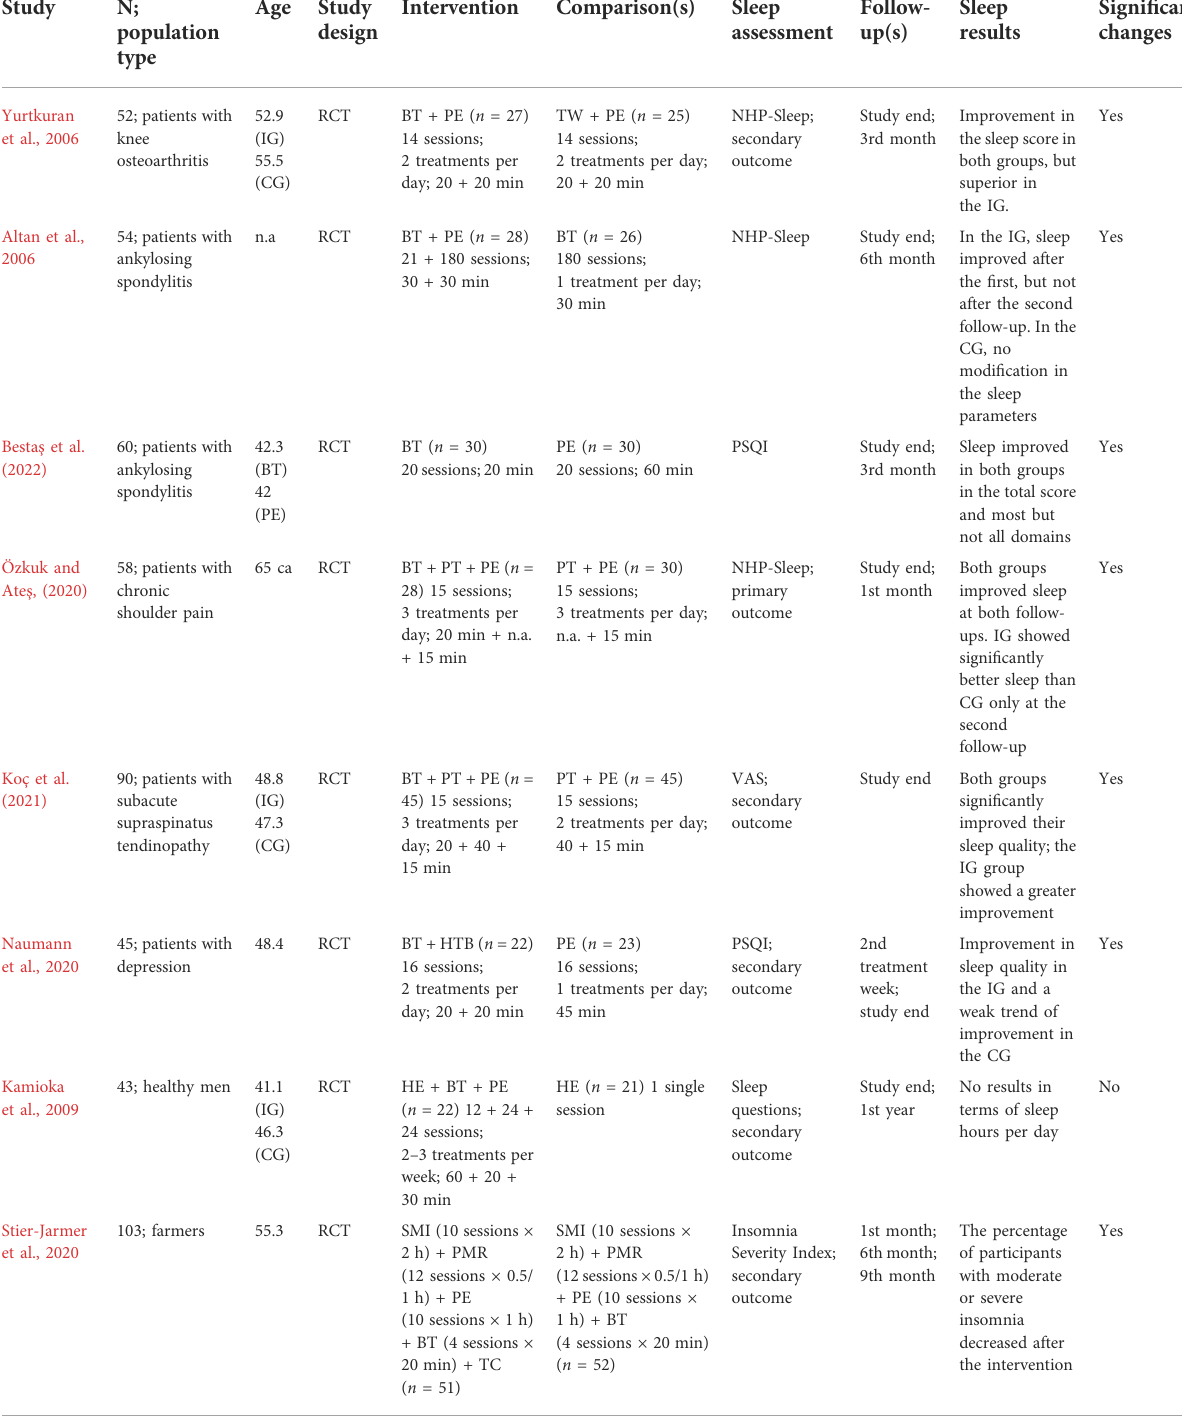
TABLE 3 Balneotherapy and physical exercise – Balneotherapy and out-of-the-pool physical exercise.